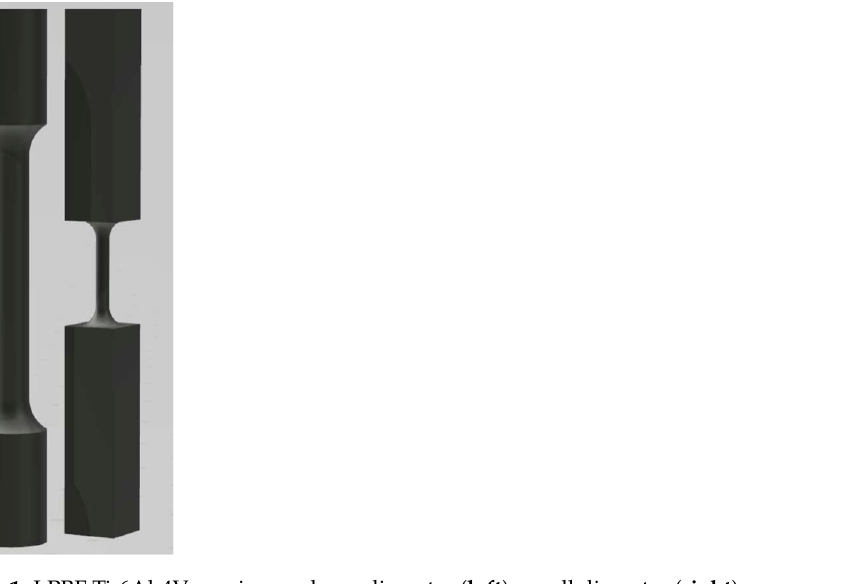
Figure 1. LPBF Ti-6Al-4V specimens: large diameter ( left ); small diameter ( right ). The arithmetical mean roughness (Ra), the total height of the roughness profile (Rt), and the mean roughness depth (Rz) were obtained according to the ISO 4287:1997 and ISO 4288:1996 standards [27,28]. Topographical data were acquired with an optical pro- filer (Sensofar-Tech SL, Pl μ 2300, Barcelona, Spain) using a 20× EPI objective (637 × 477 μ m). Data were taken from the center of the gauge length of the tensile probes. Six images were stitched together to obtain an extended measurement of the surface along the build- ing direction of the probe. In order to obtain representative surface data, several extended images were recorded at equidistant zones (six in the case of the large specimens and four in the case of the small specimens). Images contained at least 97% of the measured points of the surface. Data processing, analysis, and visualization were performed using Gwyddion software (Gwyddion 2.59, open-source software, Brno, Czech Republic, http://gwyddion.net/, accessed on 31 July 2022). The surface data were filtered in order to correct the cylindrical form and to remove spurious points. Then, a high-pass filter was applied to assess the roughness parameters with a cut-off of 0.9 mm. Five profiles along the building direction were recorded in each extended topography image. Then, the Ra, Rt, and Rz parameters were estimated by averaging data among the corresponding profile set. Roughness parameters are given as the mean and standard deviation on measure- ments. Quasi-static tensile tests were carried out at a strain rate of 0.001 s − 1 . A video exten- someter was used to record the strain and strain-controlled tests were run. The tests were performed (on the four types of specimens) following the ASTM E8-E8M standard [29]. Fatigue tests were carried out following the ISO 1099:2017 standard [30]. Specimens with the same geometry as for the quasi-static tensile tests were used for fatigue tests. Three samples of each type of specimen were tested at a constant force ratio of R = 0.1 using a sinusoidal waveform at a frequency of 15 Hz. The maximum force in the fatigue tests was selected in order to apply a stress level of 300 MPa to the specimen. According to previous studies, with this stress level, the fatigue life is expected to be around 10 5 cy- cles, which corresponds to a medium level of fatigue life for Ti-6Al-4V in PBF techniques [17,31]. The test was terminated when the sample was fractured. When the deviation from the mean number of cycles to failure was higher than 40% between specimens tested within any of the three samples, a fourth sample was tested. After the fatigue tests, fracture planes of specimens were observed by scanning elec- tron microscopy (SEM, JSM-6010LV, Tokyo, Japan). A fractographic analysis was carried